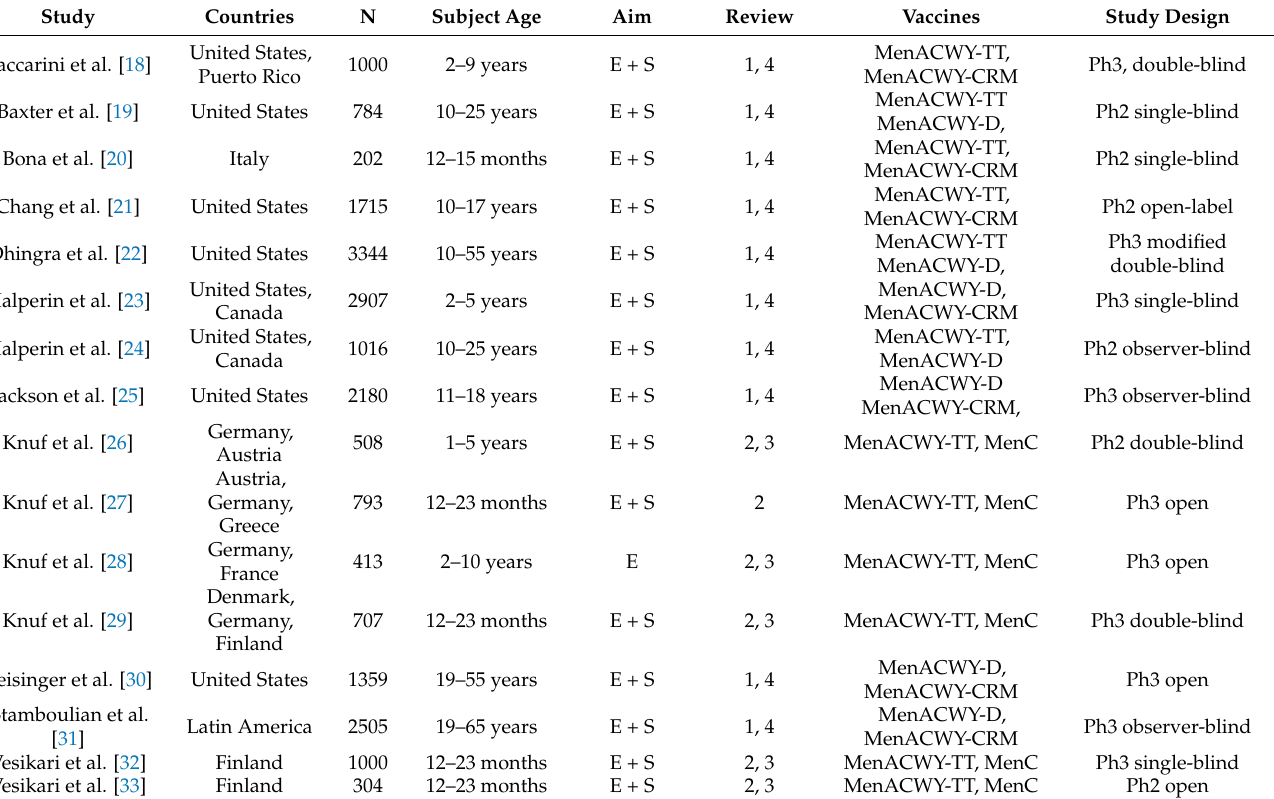
Table 2. Studies included in the systematic reviews. N: number of enrolled subjects; E: efficacy; S: safety; Review: number of the review(s) that includes the study (see Table 1); Ph2: phase 2 randomized controlled trial; Ph3: phase 3 randomized controlled